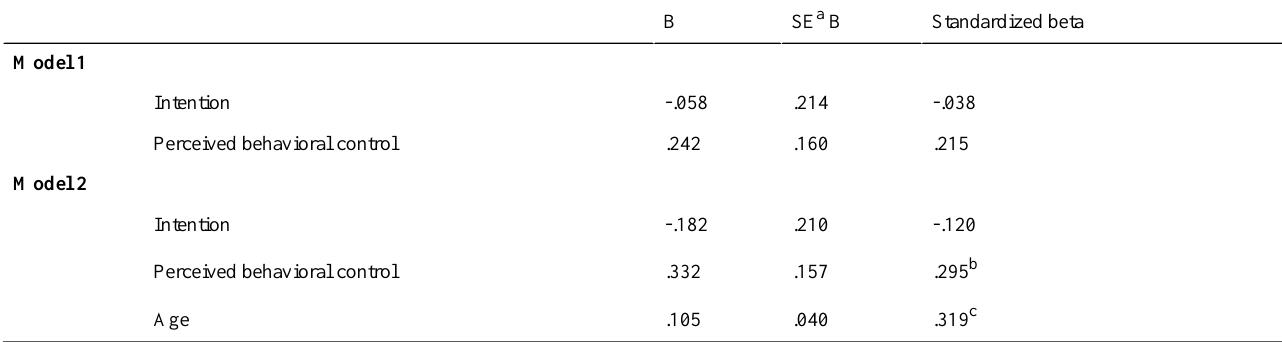
Table 4. Hierarchical multiple regression predicting retention (ie, the number of modules completed) in the online-based